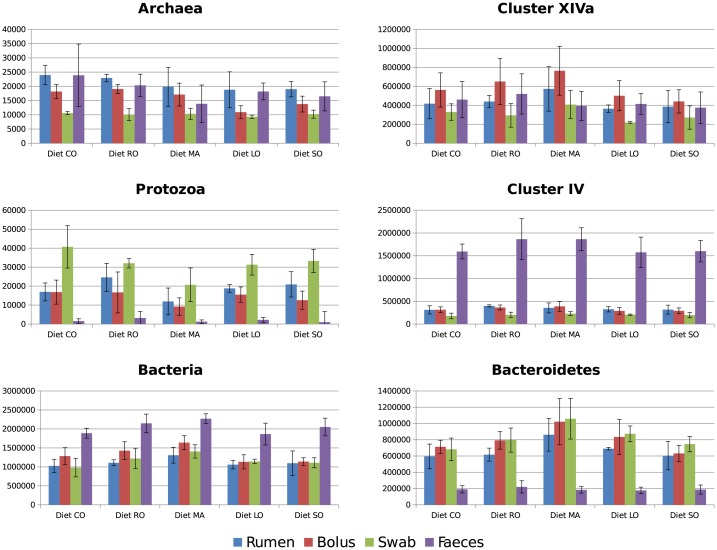
qPCR of 16S and 18S rRNA genes in buccal swabs, regurgitated digesta (bolus), ruminal digesta and faeces.Samples collected from lactating cows fed a grass silage based diet containing no additional fat (CO) or supplemented with 50 g/kg diet dry matter of methyl myristate (MA), rapeseed oil (RO), linseed oil (LO) or safflower oil (SO). Results are expressed as copy number per ng of extracted DNA. Error bars represent SD, n = 4 per treatment, except for four buccal samples, one each from CO, RO, LO and SO, from which satisfactory amplification was not obtained.